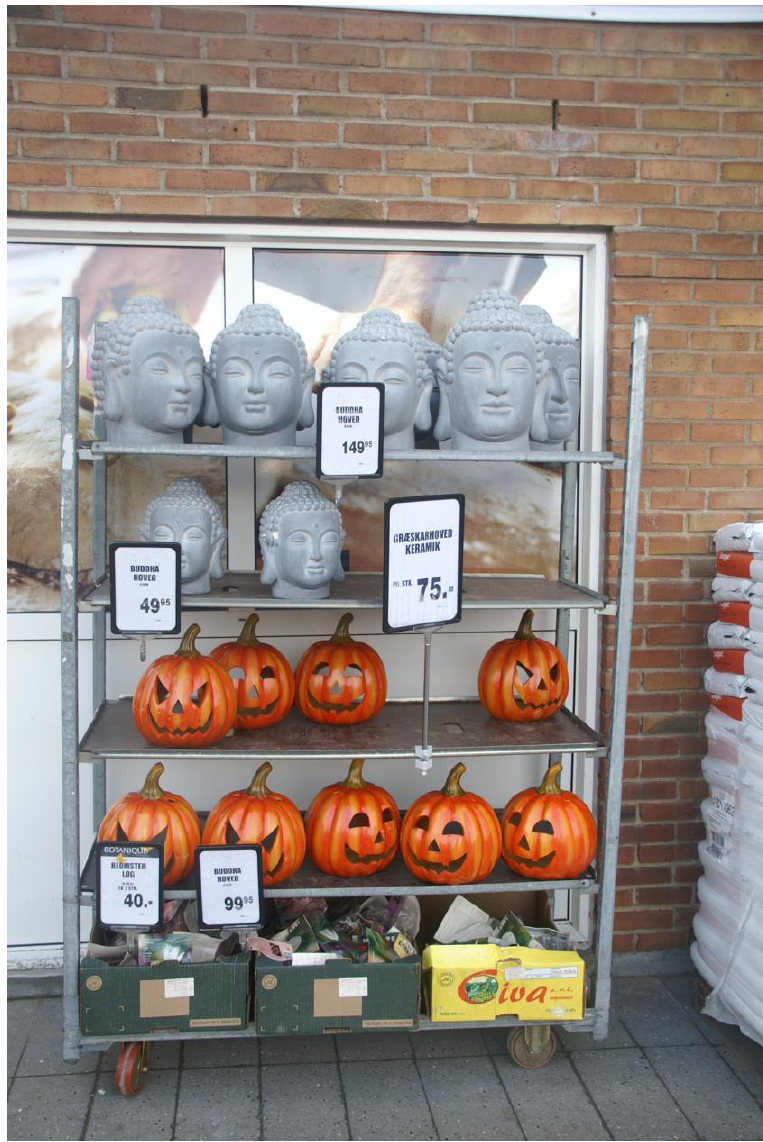
Figure 1: Buddha and pumpkins for Halloween. Photo: J.